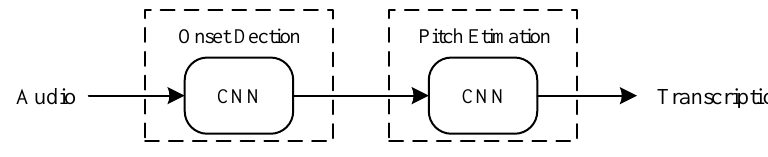
Figure 2. Diagram for the note-based acoustic